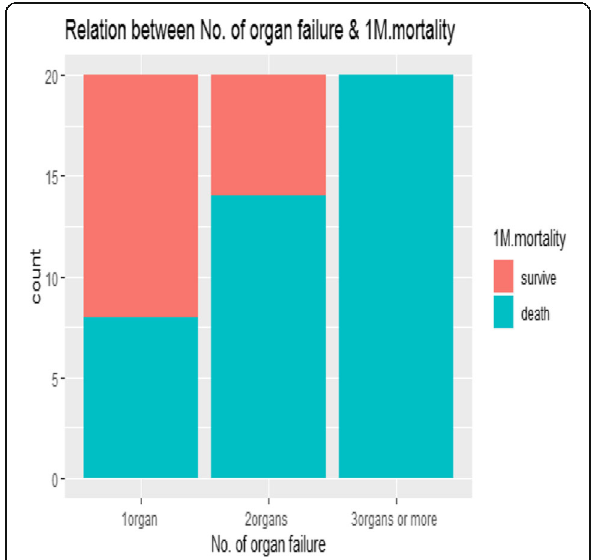
Fig. 3 Relation between no. of organ failure and 1M. mortality. Figures 3 and 4 show that there is a significant difference between no. of organ failure and both 1M. and 3M. mortalities